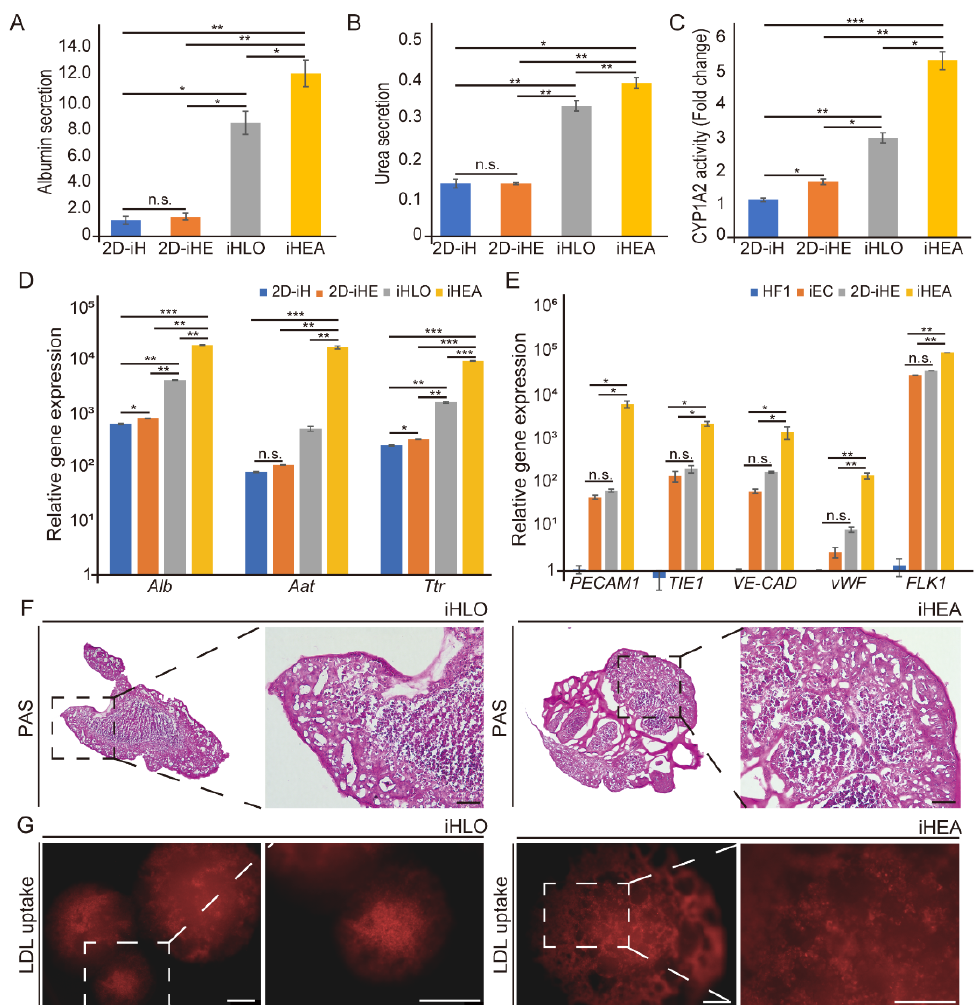
Figure 2. Hepatic functional assessment of iHLOs and iHEAs in comparison to 2D-iHs and 2D-iHEs. ( A ) The amount of albumin secretion (unit = ng/mL/μg gDNA) ( B ) and urea production (unit = ng/dl/μg gDNA) of 2D-iHs, 2D-iHEs, iHLOs, and iHEAs were examined by ELISA. Error bars indicate standard errors from triplicate samples ( n = 3). ( C ) Cyp1a2 activity of in response to 2 µ M of 3-methylcholanthrene ( n = 3). ( D ) qPCR analysis of hepatic gene expression levels ( Alb , Aat , and Ttr ) in 2D-iHs, 2D-iHEs, iHLOs, and iHEAs relative to MEFs. The transcriptional levels were normalized to the housekeeping gene ( Gapdh ). Error bars indicate standard errors from triplicate samples ( n = 3). ( E ) qPCR analysis of endothelial cell expression genes ( PECAM1 , TIE1, VE-CAD , vWF , and FLK1 ) in iECs, 2D-iHEs, and iHEAs relative to HF1. The transcriptional levels were normalized to the housekeeping gene ( GAPDH ). Error bars indicate standard errors from triplicate samples ( n = 3). * p < 0.05, ** p < 0.005, *** p < 0.0005, n.s. = not significant. ( F ) Image of Periodic acid–Schiff (PAS)-stained iHLOs and iHEAs for analysis of glycogen storage. The cells were counterstained with hematoxylin. Scale bar: 150 µ m. ( G ) Images of acetylated low-density lipoprotein (LDL) uptake in iHLOs and iHEAs. Scale bar: 250 μm .